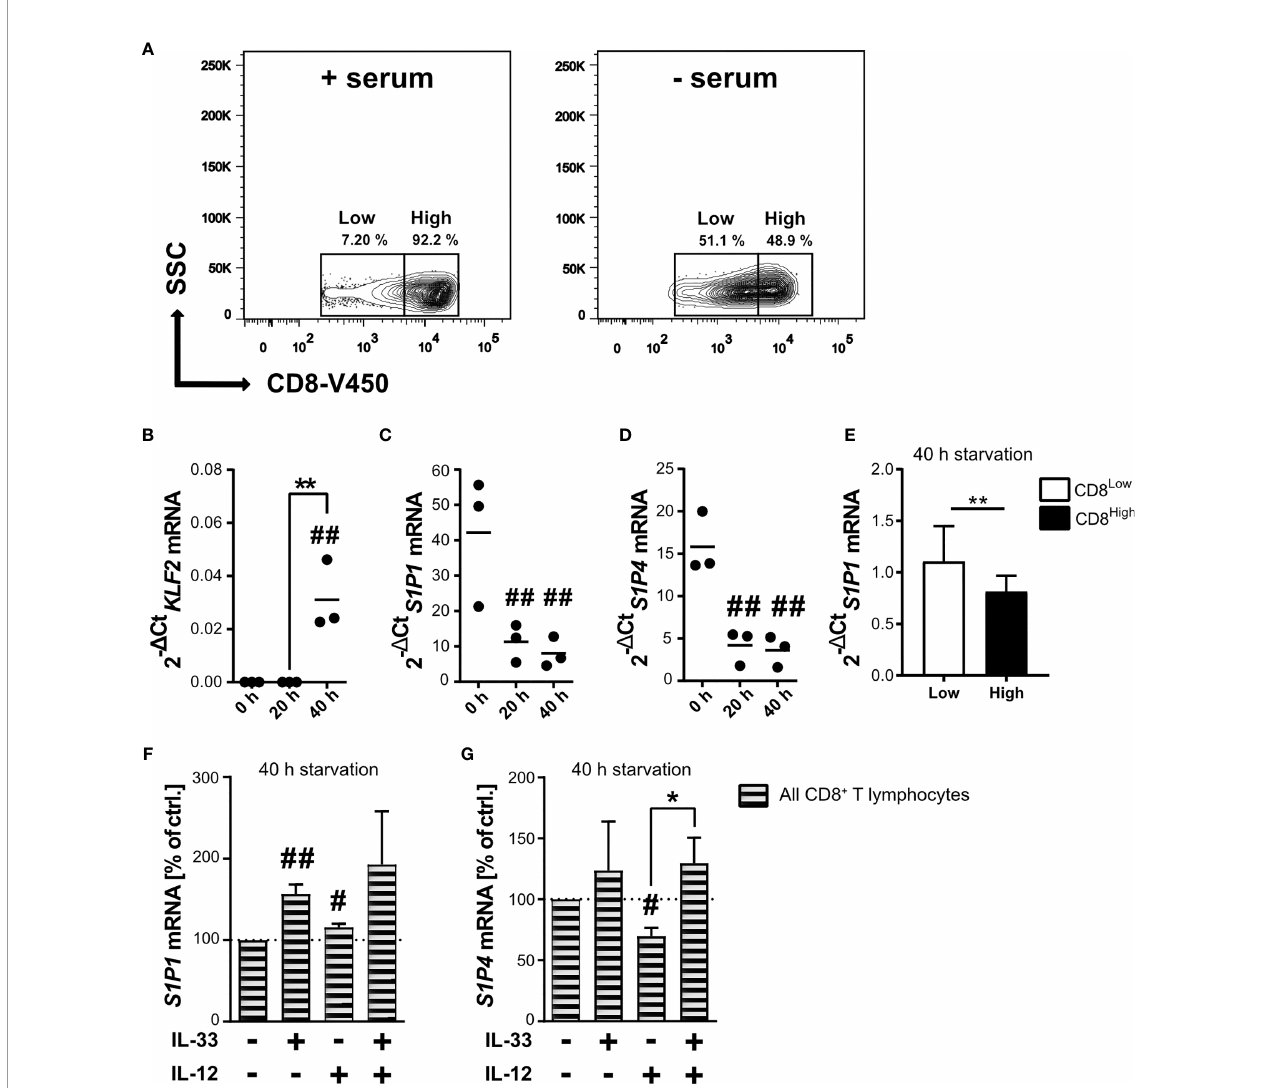
FIGURE 1 | Starvation of CD8 + T lymphocytes induces low CD8 expression (CD8 Low ) and IL-33 stimulation regulates the transcriptional levels of S1P 1 and S1P 4 mRNA. (A) CD8 + T lymphocytes were puri fi ed from human buffy coats, cultivated with 10% autologous donor serum (left) or without serum (right) for 40 h. Representative contour plots show gating of low and high CD8 (V450) expression, which was analyzed by fl ow cytometry. Total RNA of CD8 + T lymphocytes was extracted directly after isolation, and after 20 h or 40 h of cultivation under serum starvation for qRT-PCR analysis of KLF2 (B) , S1P 1 (C, E, F) , S1P 4 (D, G) . (E) **p < 0.01, for comparisons between CD8 Low und CD8 High using Wilcoxon matched-pairs signed rank test. Data are obtained from n = 9 donors. (F, G) Lymphocytes were additionally stimulated with IL-33 (20 ng/mL) and/or IL-12 (5 ng/mL). Data are shown as individual values obtained from n = 3 different donors of three independently performed experiments. The horizontal line indicates the mean. Bars show mean ± SD. # p ≤ 0.05, ## p < 0.01 for comparisons to the 0 h time point. *p ≤ 0.05, using one-way ANOVA with Tukey´ s